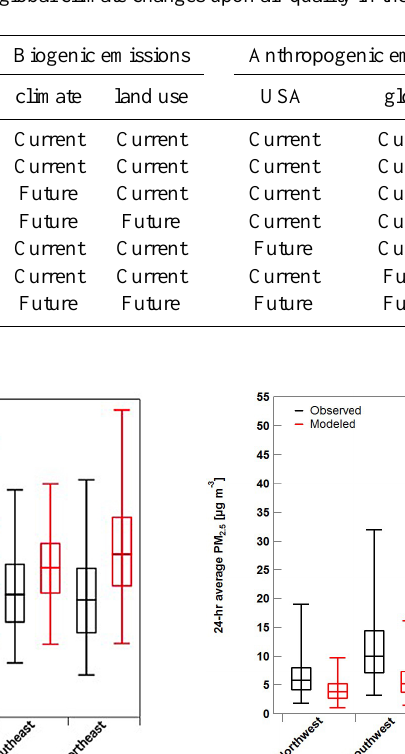
Table 1. List of simulations to assess the effect of global climate changes upon air quality in the United States.